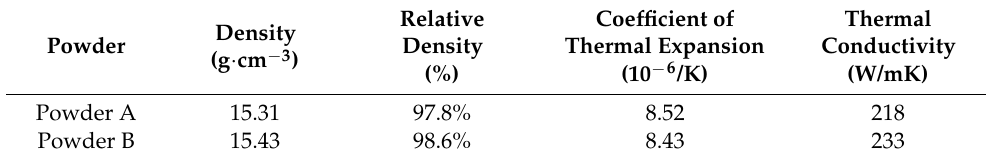
Table 4. Properties of the W–20% Cu composite sintered from powders A and